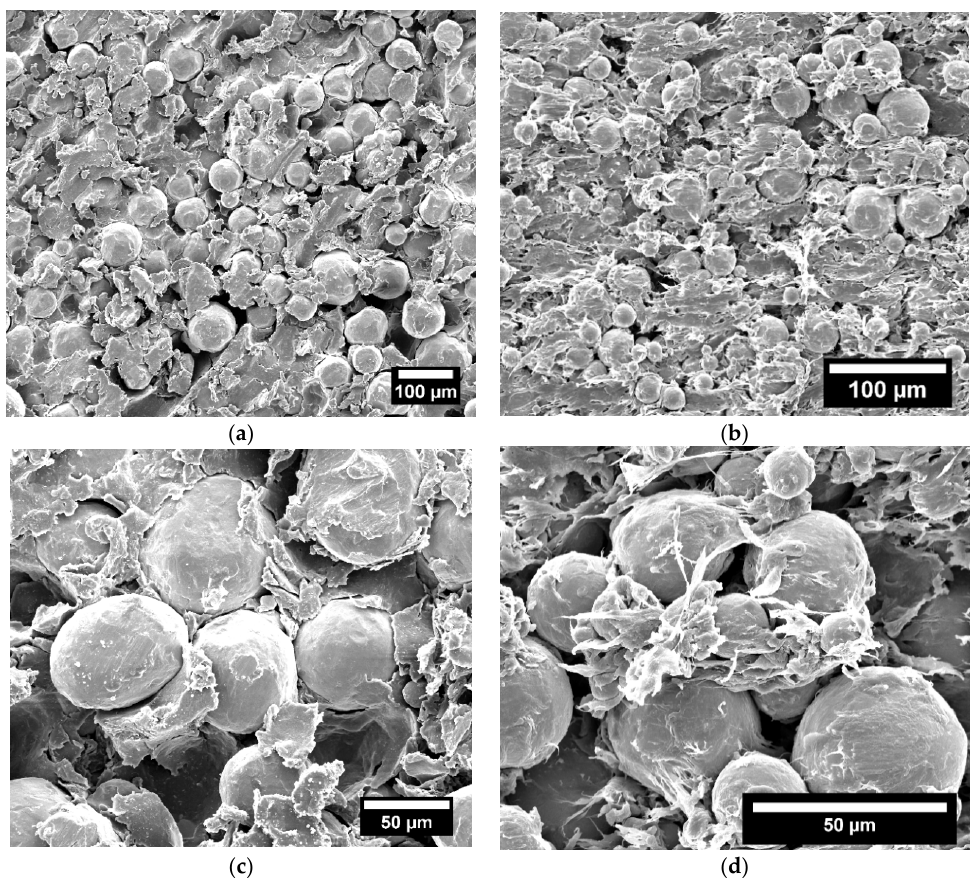
Figure 6. SEM images of the surface of as-broken samples of feedstocks from: ( a ) the current study at low magnification; ( b ) commercial at low magnification; ( c ) the current study at high magnification; ( d ) commercial at high magnification.